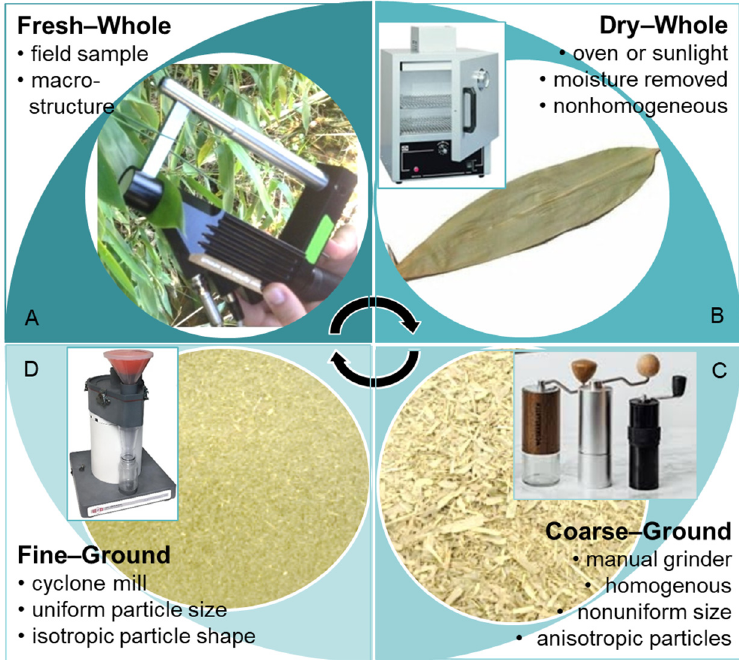
Figure 1. Four processing modes of forage samples: ( A ) Fresh–Whole, ( B ) Dry–Whole, ( C ) Coarse– Ground, and ( D ) Fine–Ground.